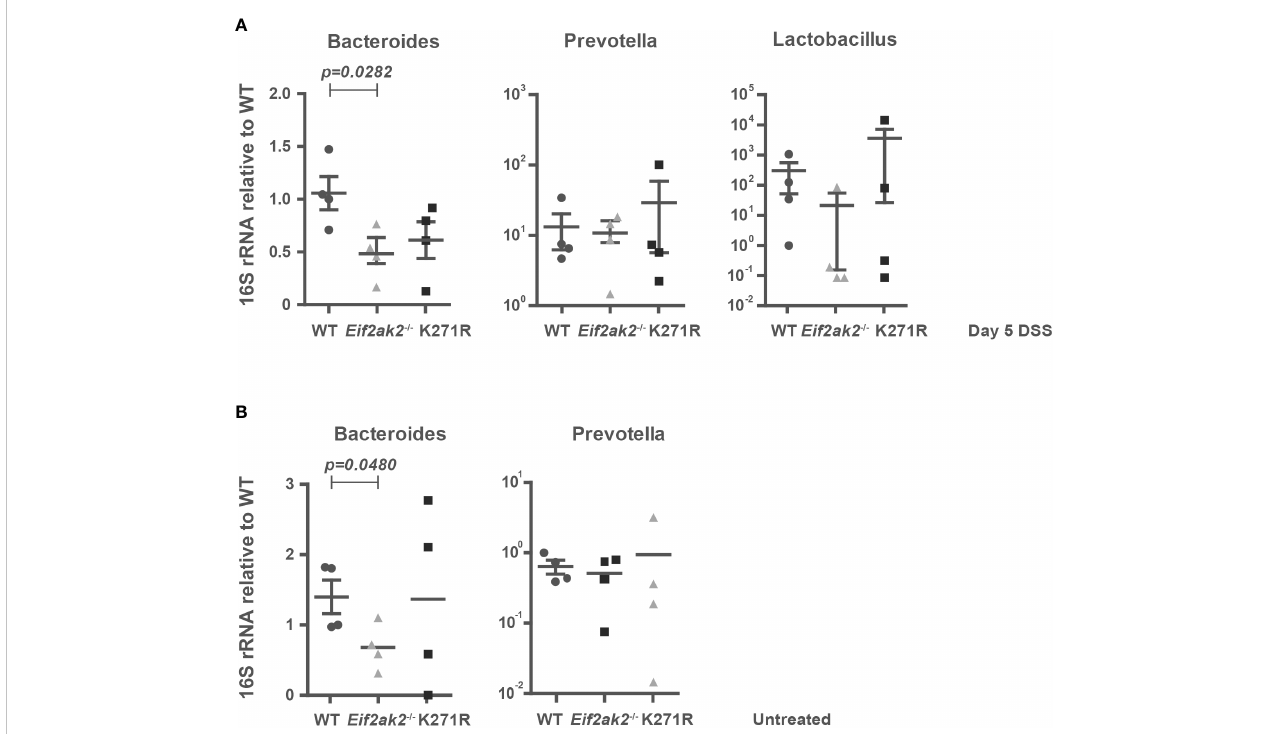
FIGURE 8 PKR affects the gut fl ora. (A, B) The amounts of Bacteroides , Prevotella and Lactobacillus species in fecal samples from WT, PKR-ablated ( Eif2ak2 -/- ) and kinase-dead (K271R) mice either (A) treated with DSS or (B) untreated (n=4). The quantities of bacteria were assessed by Q-PCR ampli fi cation of species- speci fi c 16S rRNA and are expressed as fold induction of bacterial content compared to WT mice. The data are expressed as mean ± S.E.M. and analyzed by one-way ANOVA with Tukey ’ s range